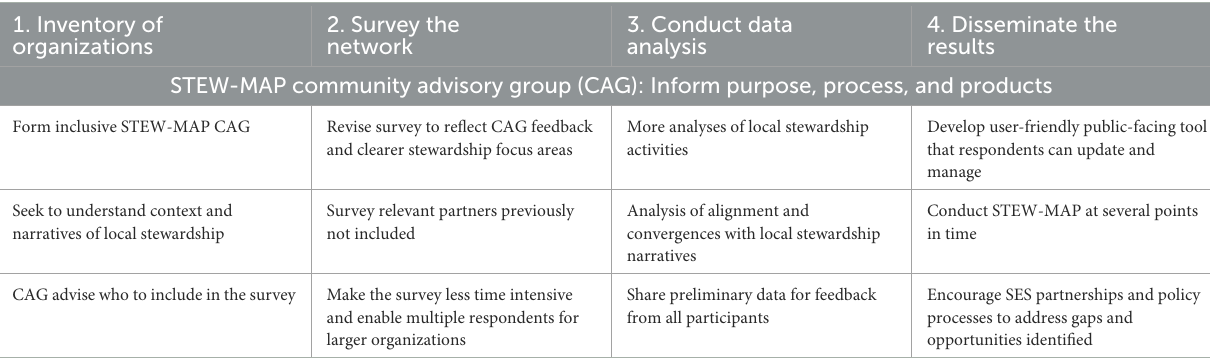
TABLE 1 LA STEW-MAP recommendations by